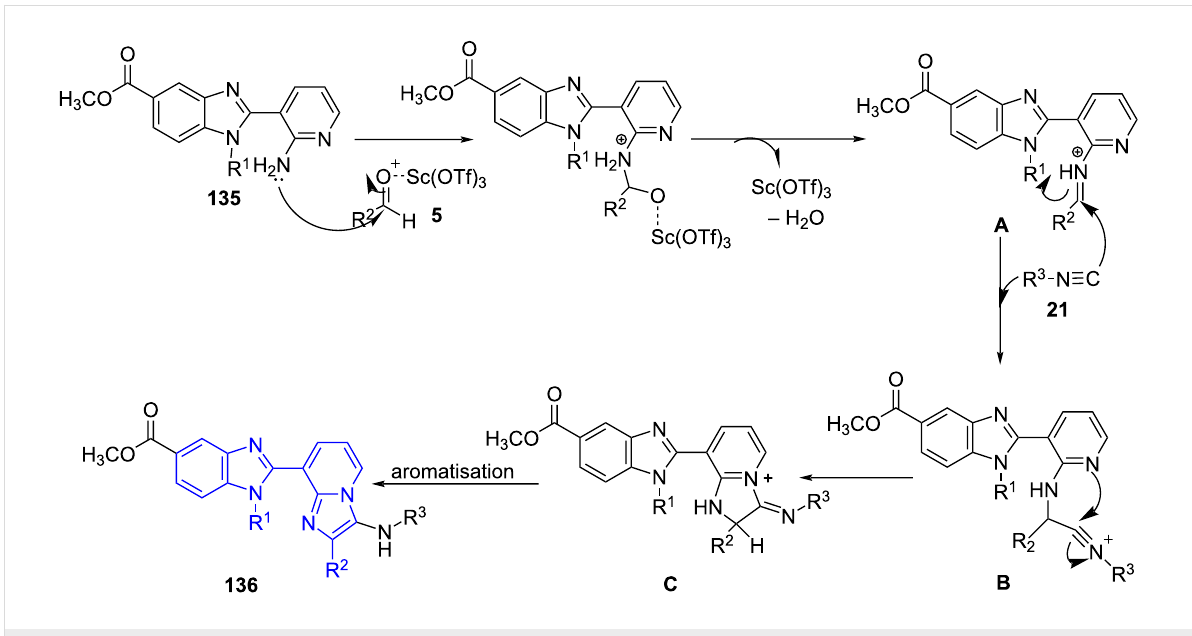
Scheme 52: Mechanism for the synthesis of benzimidazole-imidazo[1,2- a